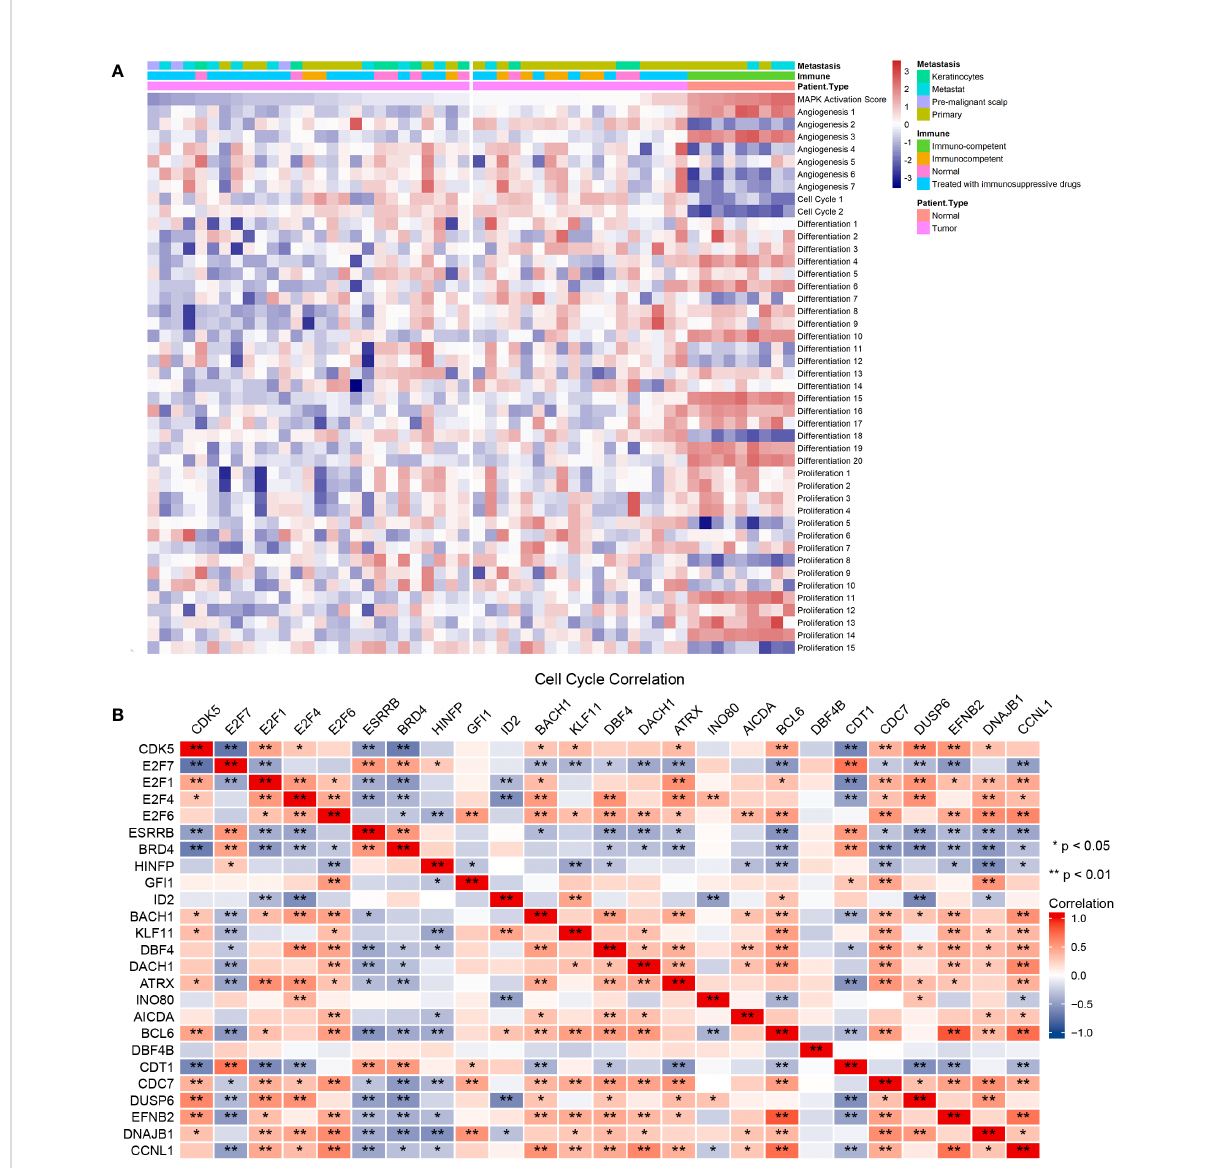
FIGURE 4 The four cSCC-PDT-related genes were correlated with the cell cycle gene. (A) The result of ssGSEA analysis of GSE98767 sorted by MAPK activation level. (B) Correlation coef fi cient matrix of four cSCC-PDT-related genes and cell cycle